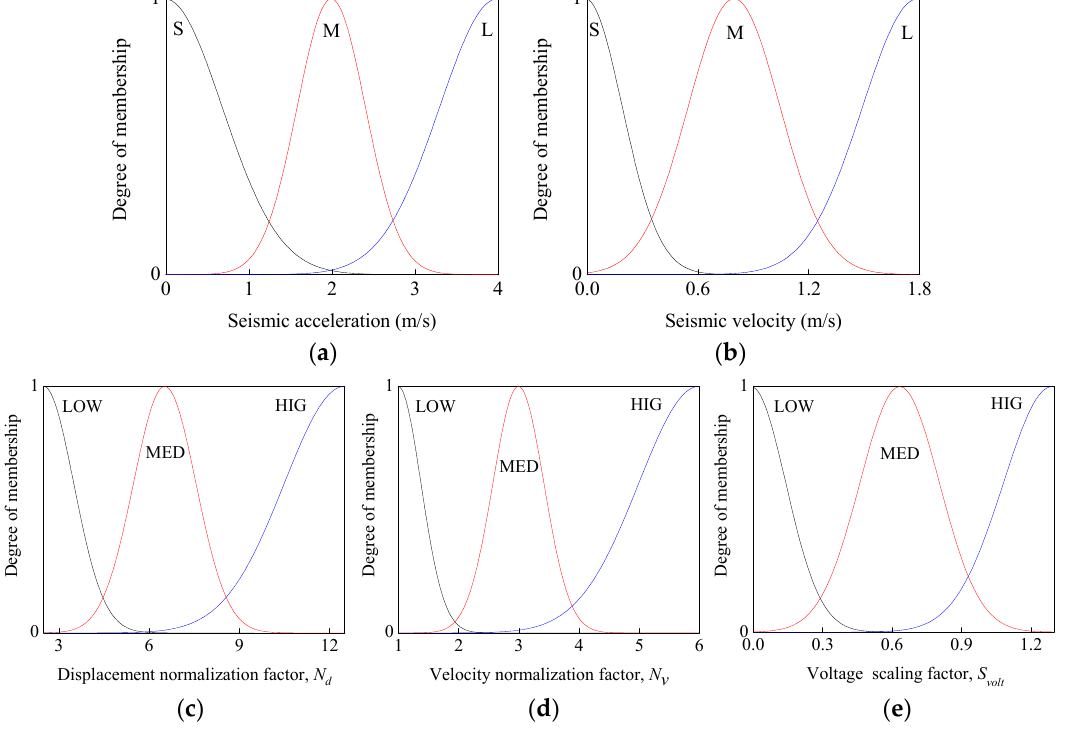
Figure 7. Input and output membership functions for supervisory FLC: ( a ) input seismic acceleration; ( b ) input seismic velocity; ( c ) output displacement normalization factor; ( d ) output velocity normalization factor; and ( e ) output voltage scaling factor.